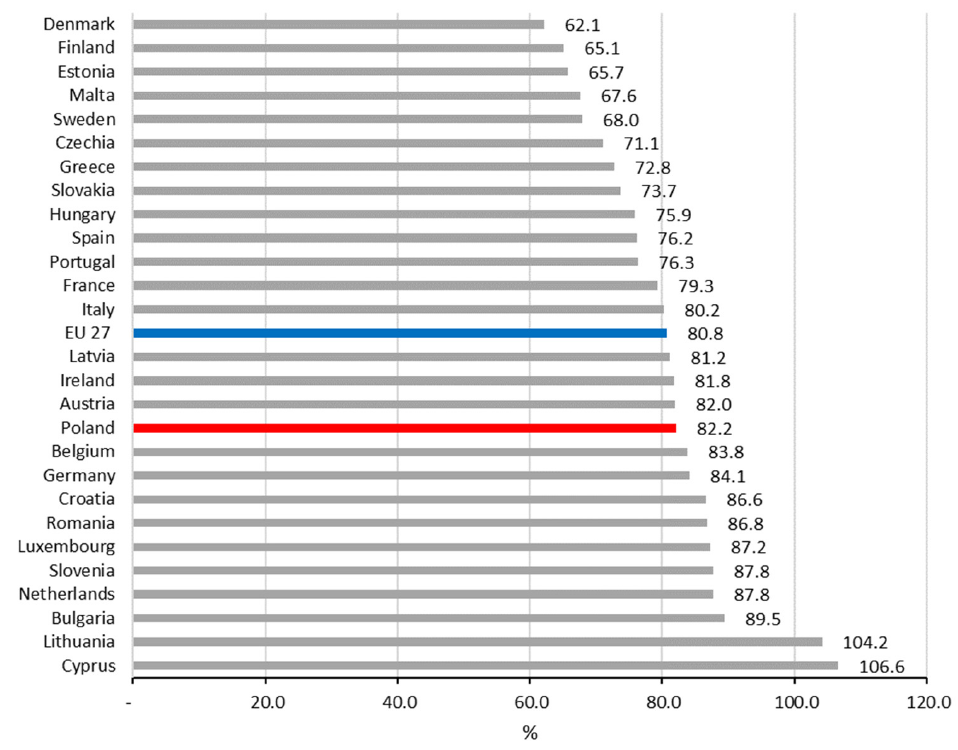
Figure A2. Greenhouse gas emissions intensity of energy consumption by EU27 country in 2020. Index, 2000 = 100. Source: own elaboration based on [27].